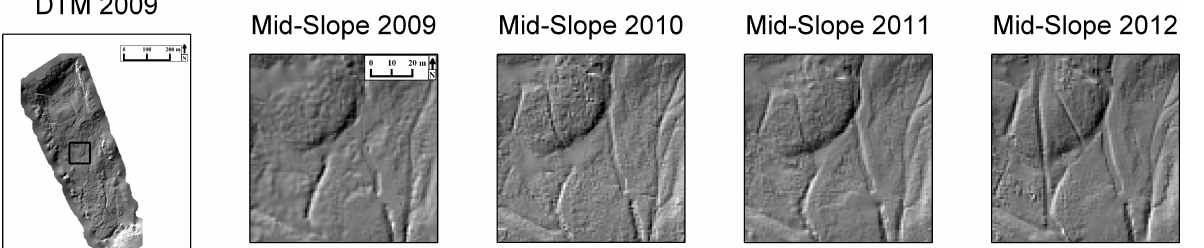
Figure 12. The evolution of a mid-slope subset area of the landslide (that was very active in years 2003–2006; see Figure 5) in shaded DTMs of the years